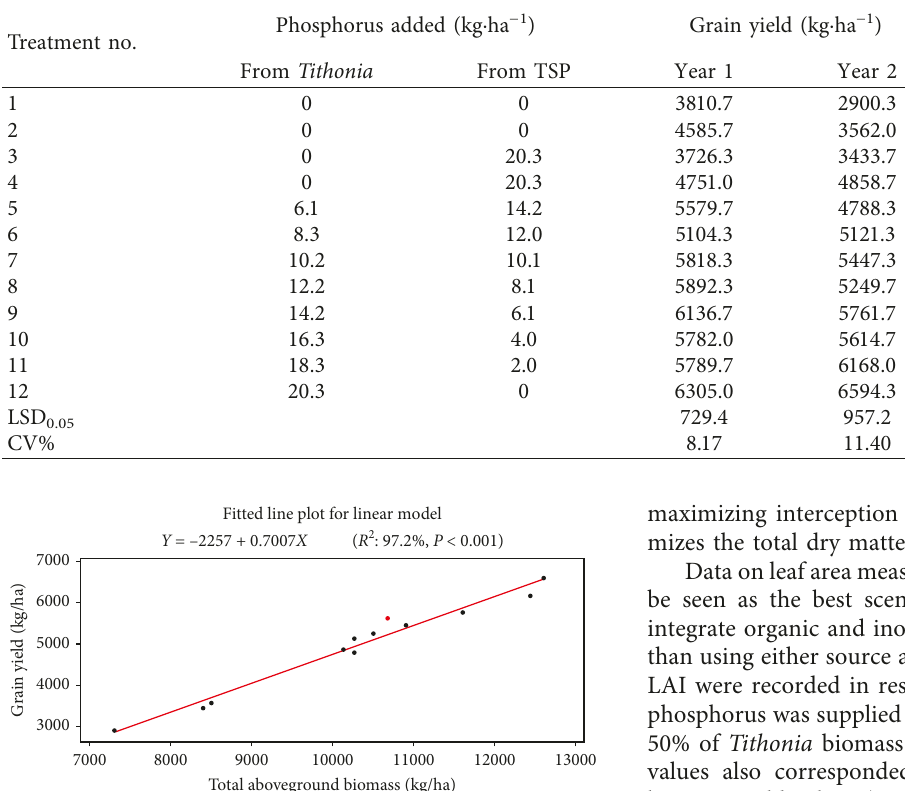
Figure 4: Relationship between grain yield and total aboveground biomass of maize.